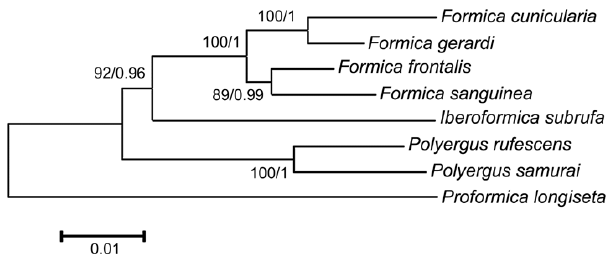
Fig 6 . Phylogenetic tree using concatenated sequences of the abdominal A, wingless, long-wavelength rhodopsin nuclear genes and the mitochondrial cytochrome oxidase I gene. First number at nodes indicates the bootstrap values obtained in the maximum likelihood analysis (only when higher than 70%) and the second one the posterior probability values in the Bayesian inference analysis (only when higher than